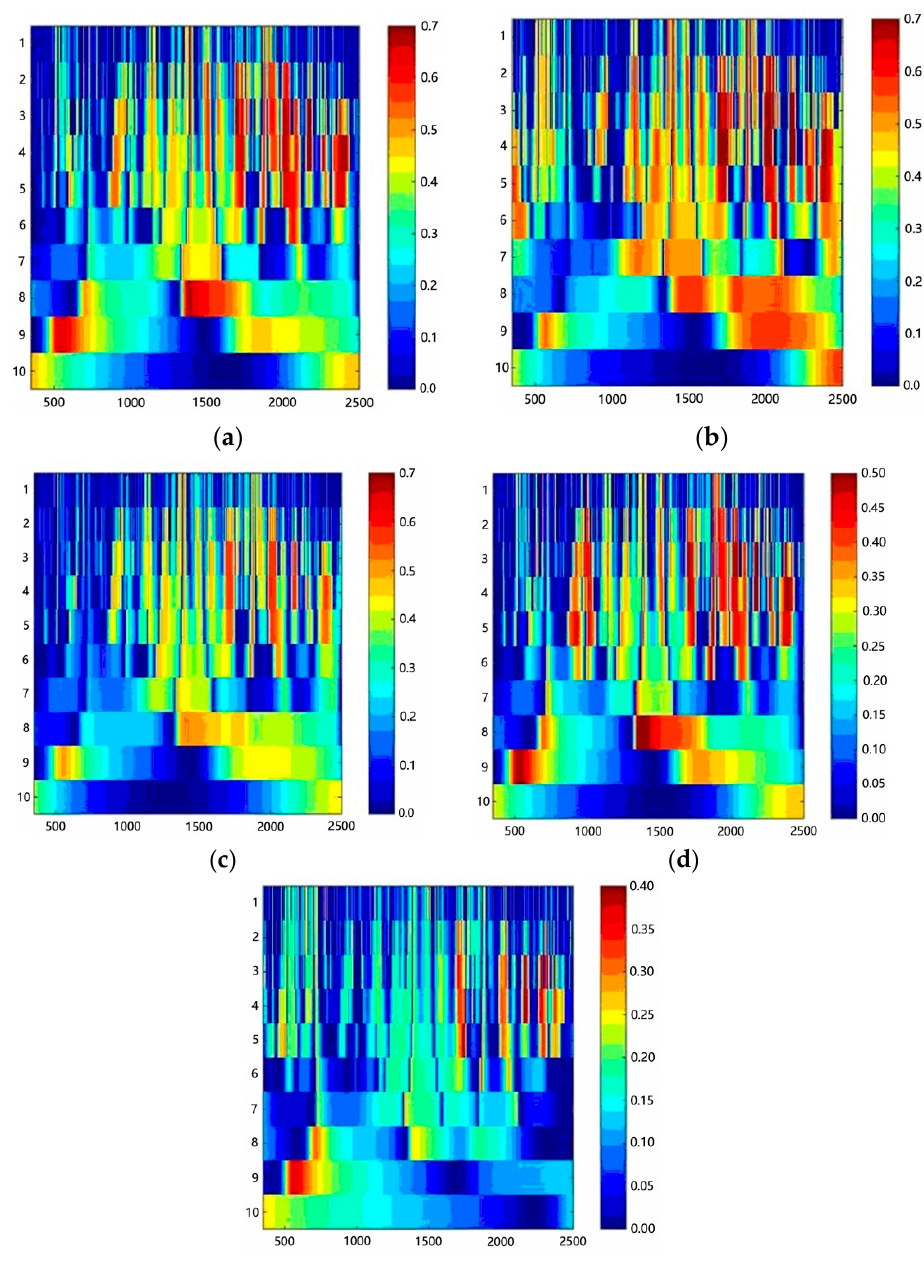
Figure 4. Correlation matrix diagrams of wavelet coefficients and leaf nitrogen content in different leaf positions. ( a ) Flag leaf; ( b ) upper 1 leaf; ( c ) upper 2 leaf; ( d ) upper 3 leaf; ( e ) upper 4 leaf. Based on the wavelet coefficients obtained by the CWT, the sensitive wavelet energy coefficients were screened, and the results are shown in Table 6. Correlations of different leaf position wavelet coefficients and leaf nitrogen content in winter wheat.